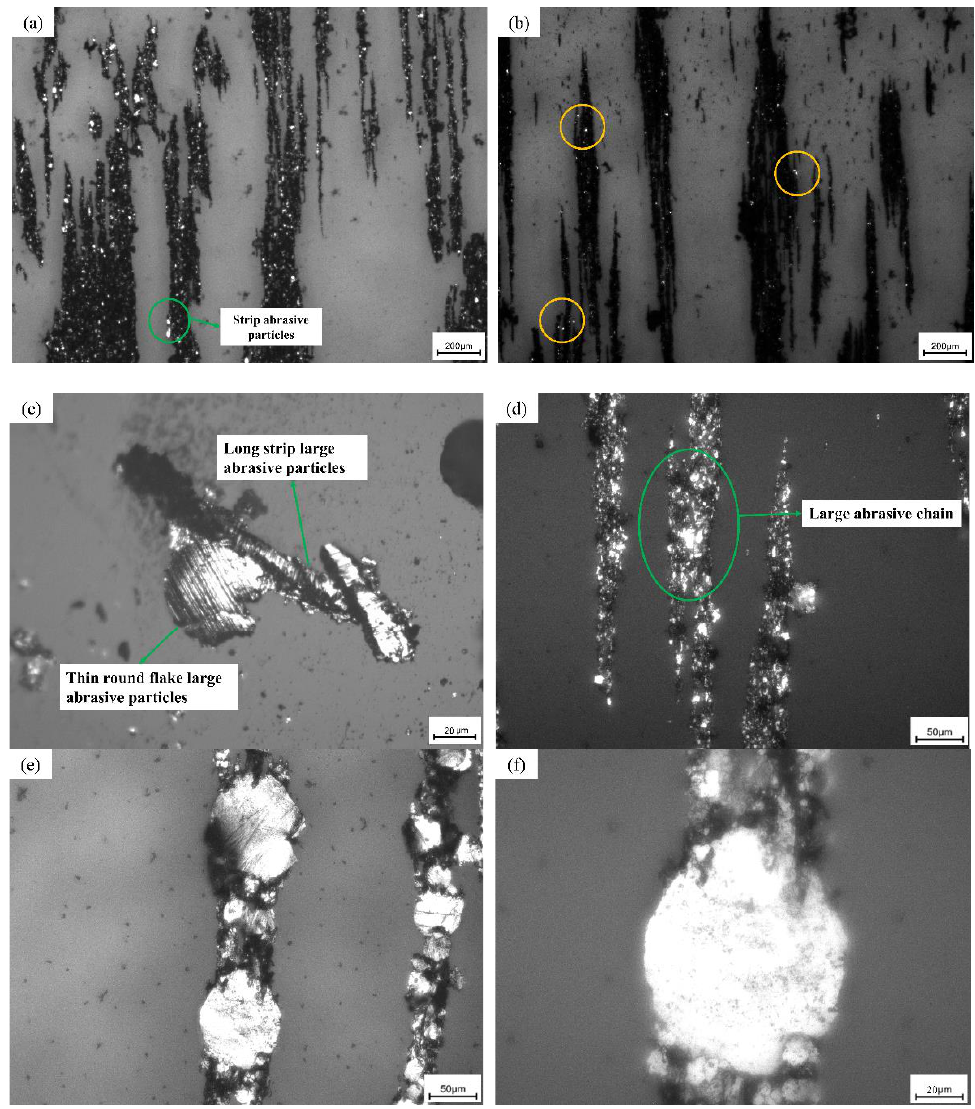
Figure 7. ( a ) Ferrograph of the experimental group in the running-in wear stage; ( b ) ferrograph of the control group in the running-in wear stage; ( c ) 500 times larger abrasive grains in the shape of smooth round and long strips; ( d ) 200 times the large abrasive chain in the severe wear stage; ( e ) smooth, round abrasive grains under 300× magnification; ( f ) Light, rounded large abrasive grains under 500× mirror.